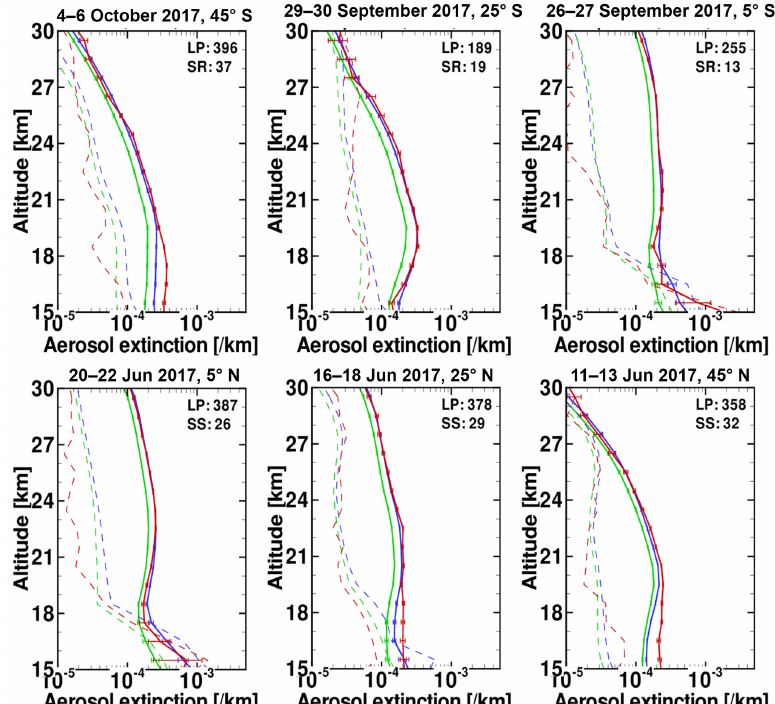
Figure 11. Comparison of zonal mean profiles of collocated SAGE III/ISS (red solid lines), LP Version 1 (green solid lines) and LP Version 1.5 (blue solid lines) aerosol extinction profiles for six different ± 5 ◦ latitude bins centered at 45 ◦ S, 25 ◦ S, 5 ◦ S, 5 ◦ N, 25 ◦ N and 45 ◦ N. The dashed lines show the corresponding standard deviations. The horizontal error bars indicate standard error of the mean, σ / numbers at the top shows the number of measurements averaged for each